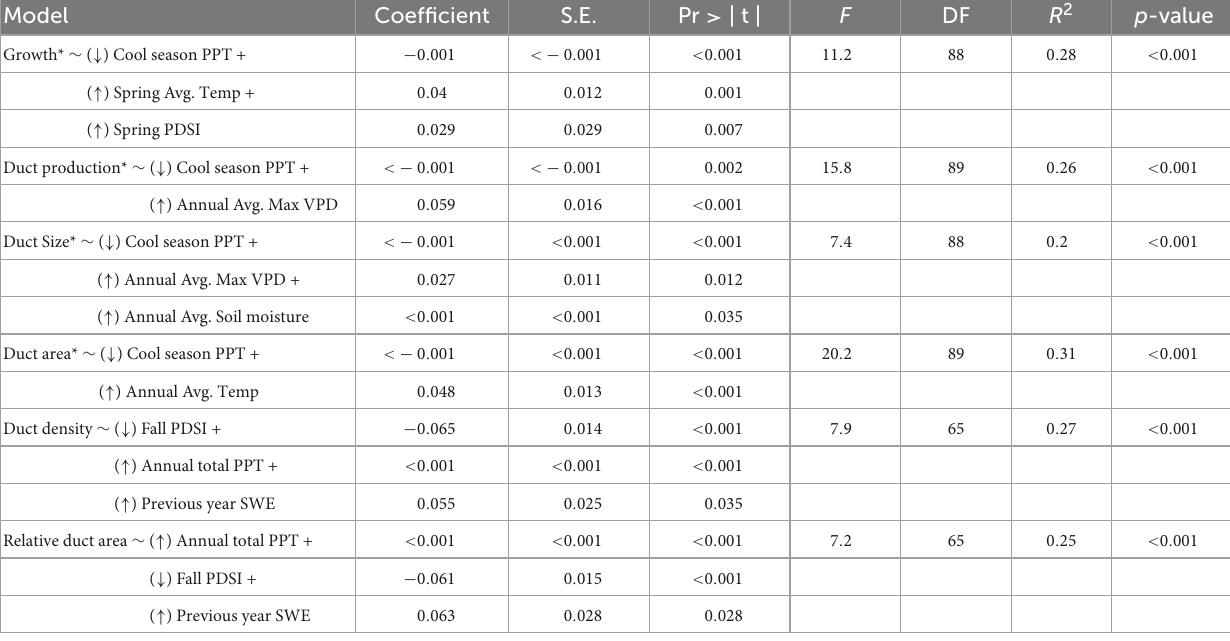
TABLE 2 Top climate models predicting tree growth (ring width index, RWI), detrended duct production/size/area, and standardized duct metrics (duct density and relative duct area) as determined by best subsets regression. Model Coefficient S.E.